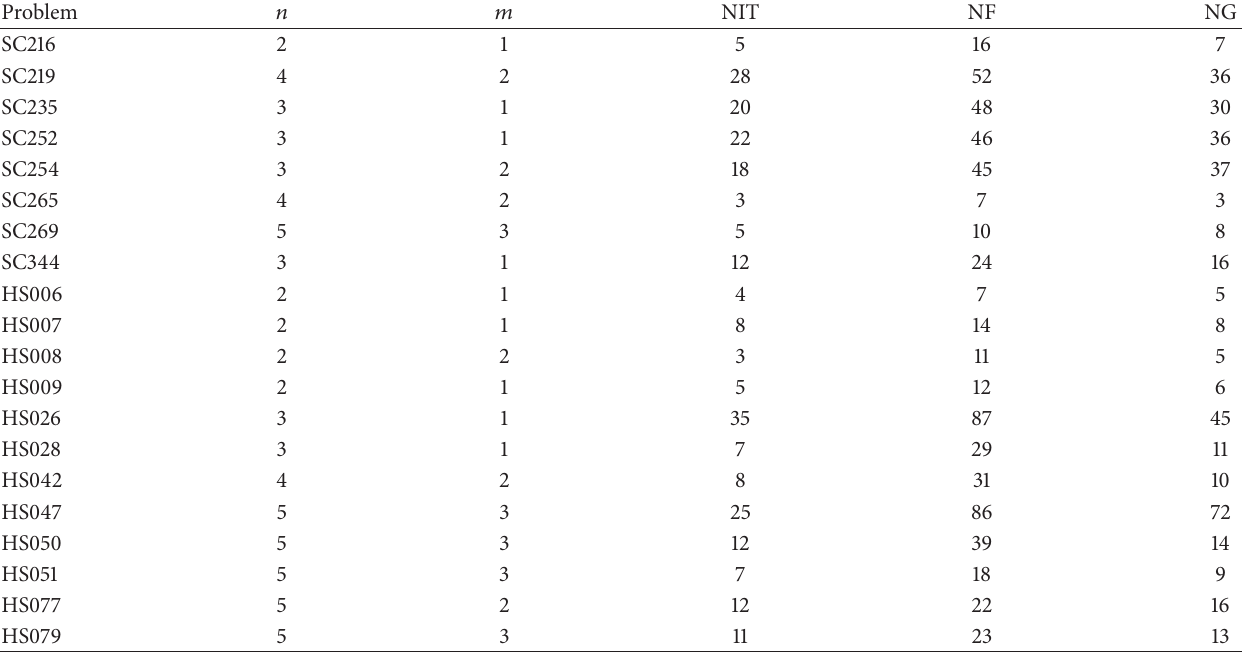
Table 1: Detailed numerical results.